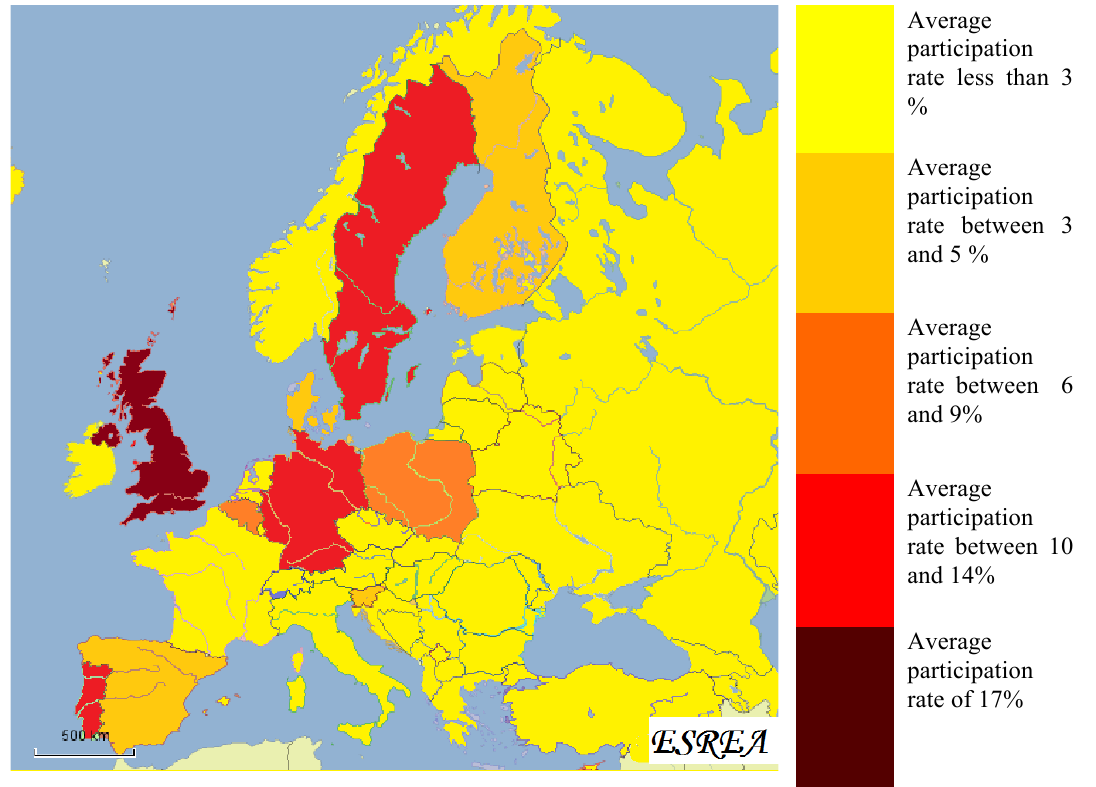
Figure 1: ESREA conferences and national participation